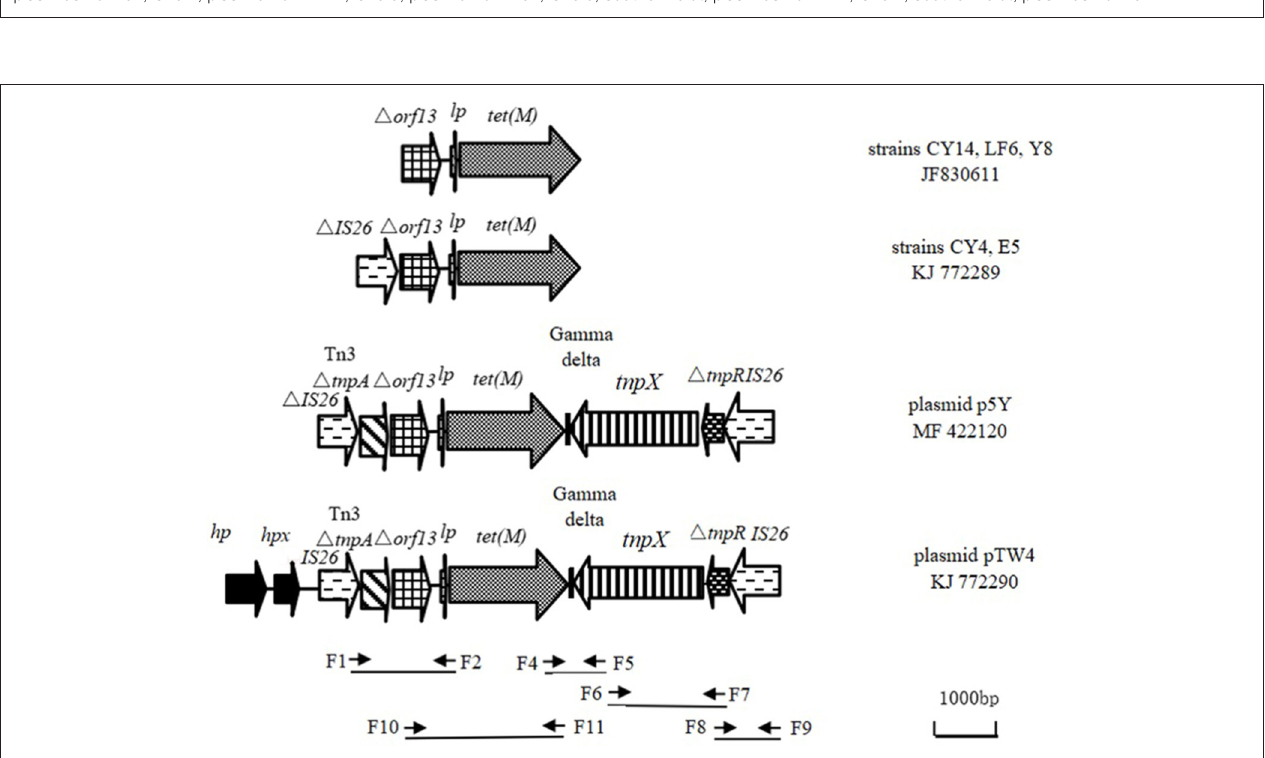
FIGURE 2 | Location of tet (M) in clinical isolates of E. coli and graphical representation of primer pairs along the tested genetic structure KJ772290 ( hp ), gene encoding hypothetical protein; hpx , gene encoding putative protein X; lp , gene encoding Tet(M) leader peptide; fragment between A and B position in the sequence KJ772290 was obtained by cloning experiments. Arrows represent the orientation of each primer and relative positions of the primers along the tested linear sequence.